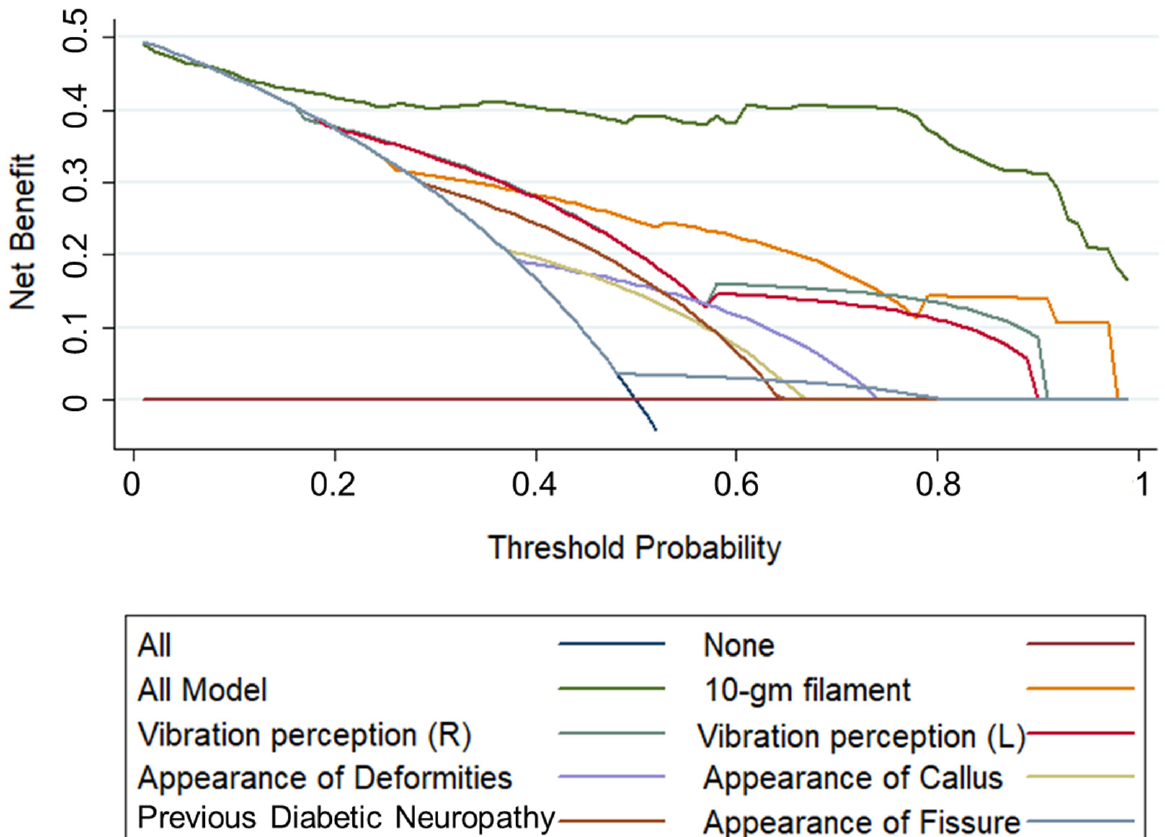
Figure 3. Calibration plot comparing actual and predicted DSPN probability for ( a ) the internal val- idation and ( b ) the external validation.